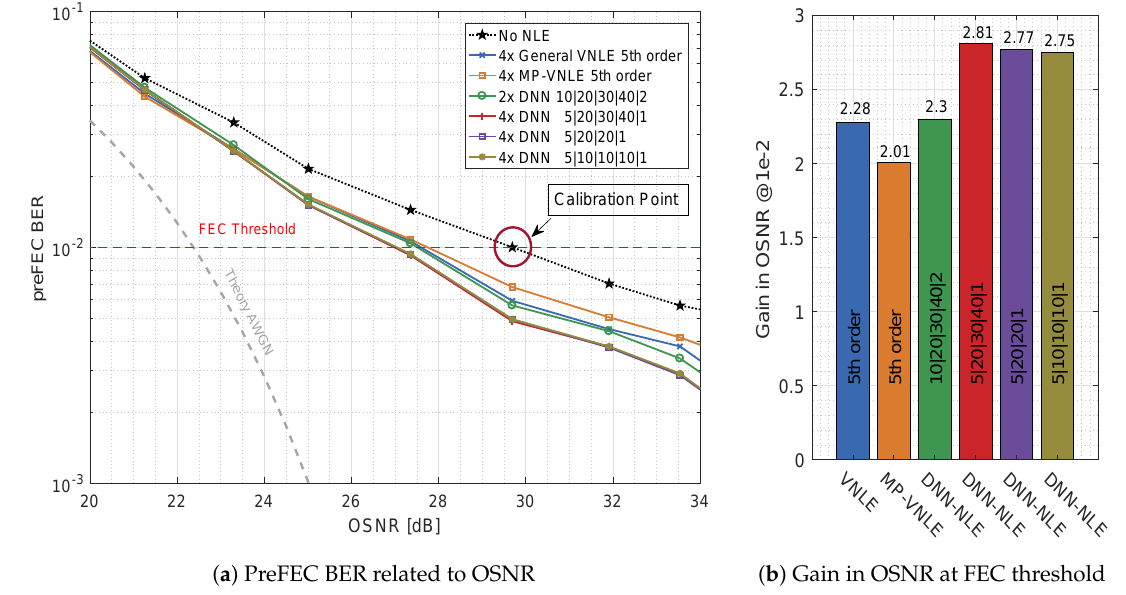
Figure 12. Optical Back-to-Back 660 Gb/s/ λ postFEC BER measurements results applying different Volterra and deep neural network